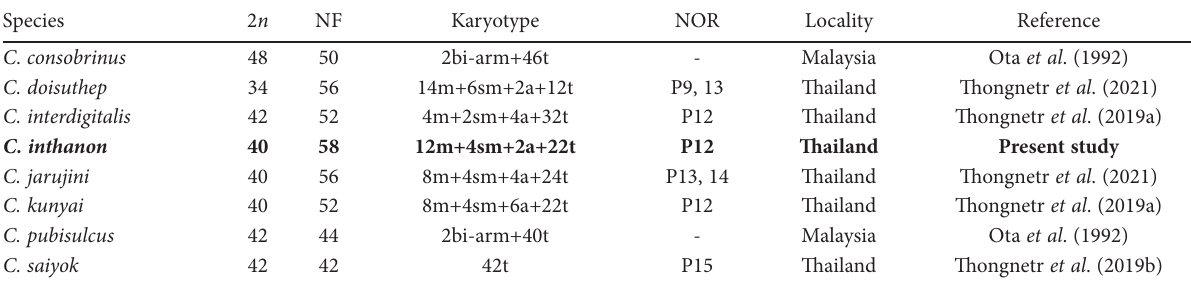
Table 1. Karyotype reviews in the genus Cyrtodactylus. Species 2 n